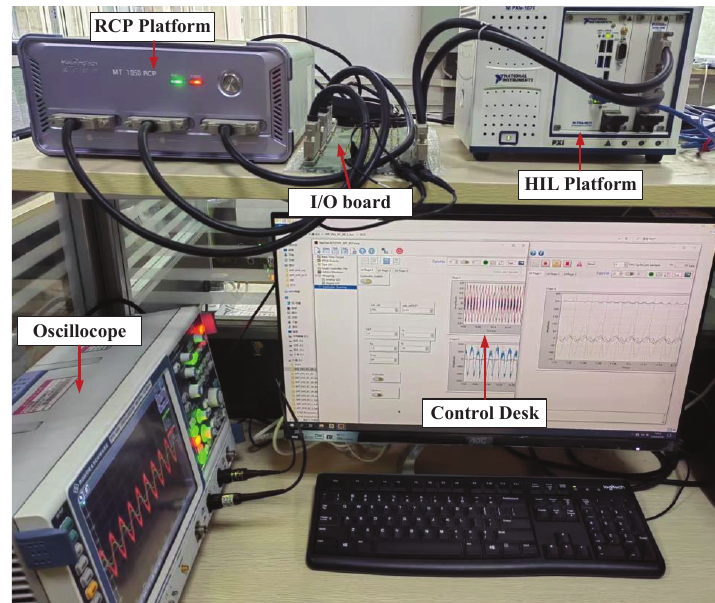
Figure 13. Experiment